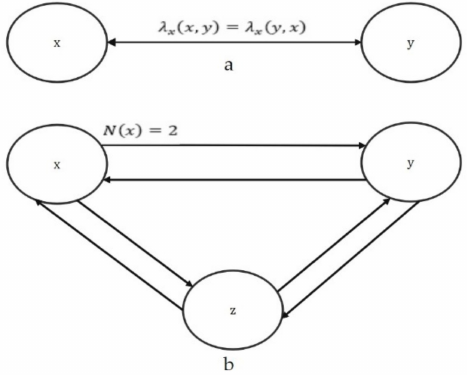
Figure 2. Bidirectional channel among nodes: ( a ) bidirectional form. ( b ) neighbors